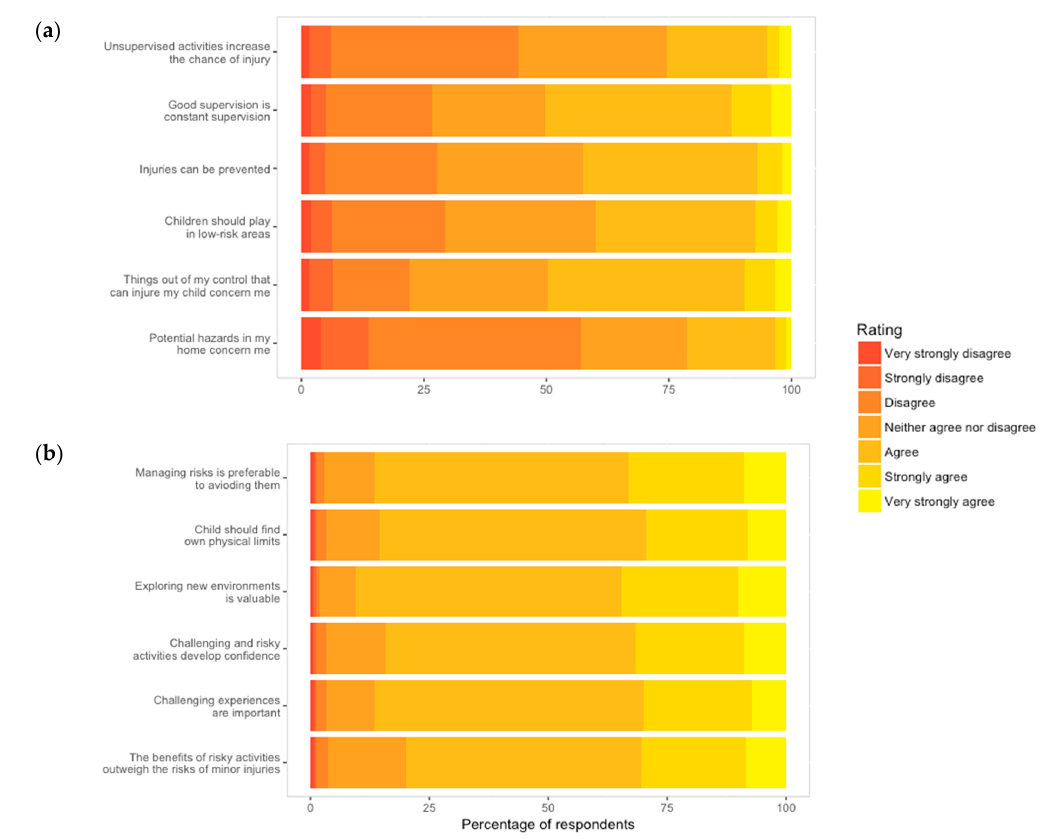
Figure 3. Risk Engagement and Protection Survey (REPS) responses to ( a ) injury prevention and ( b ) risk engagement questions.